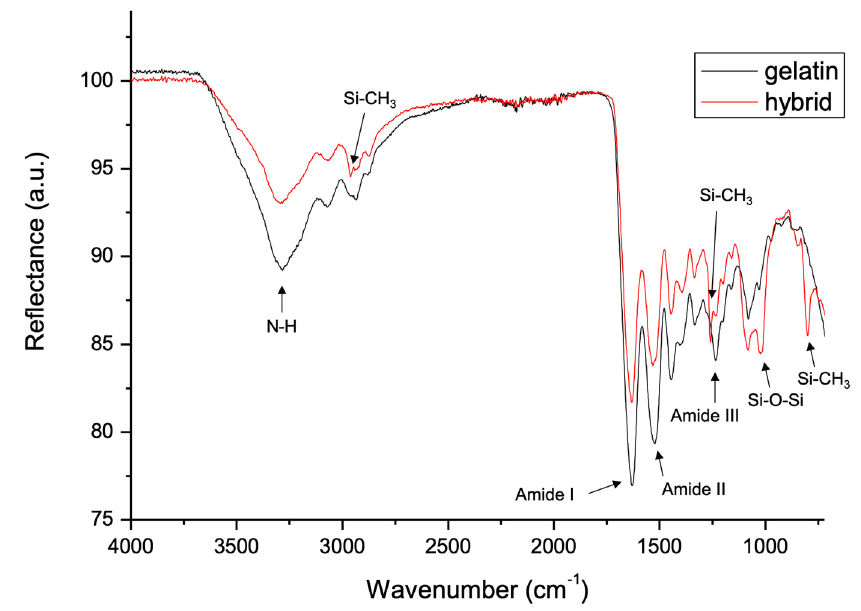
Figure 3. FTIR spectra of unmodified gelatin and gelatin-siloxane hybrid (GS 1:1).